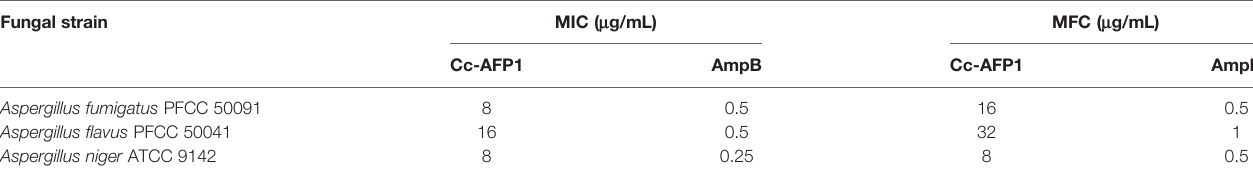
TABLE 1 | MIC and MFC values ( m g/mL) of Cc-AFP1 and amphotericin B (AmpB) for Aspergillus species. Fungal